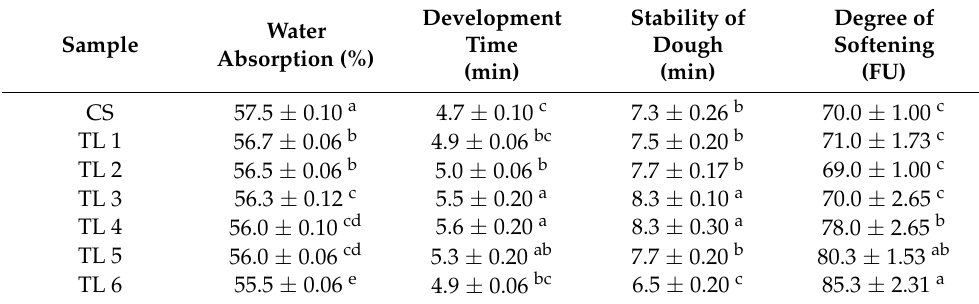
Table 1. Farinograph indices for wheat flour and wheat flour with Taraxacum officinale